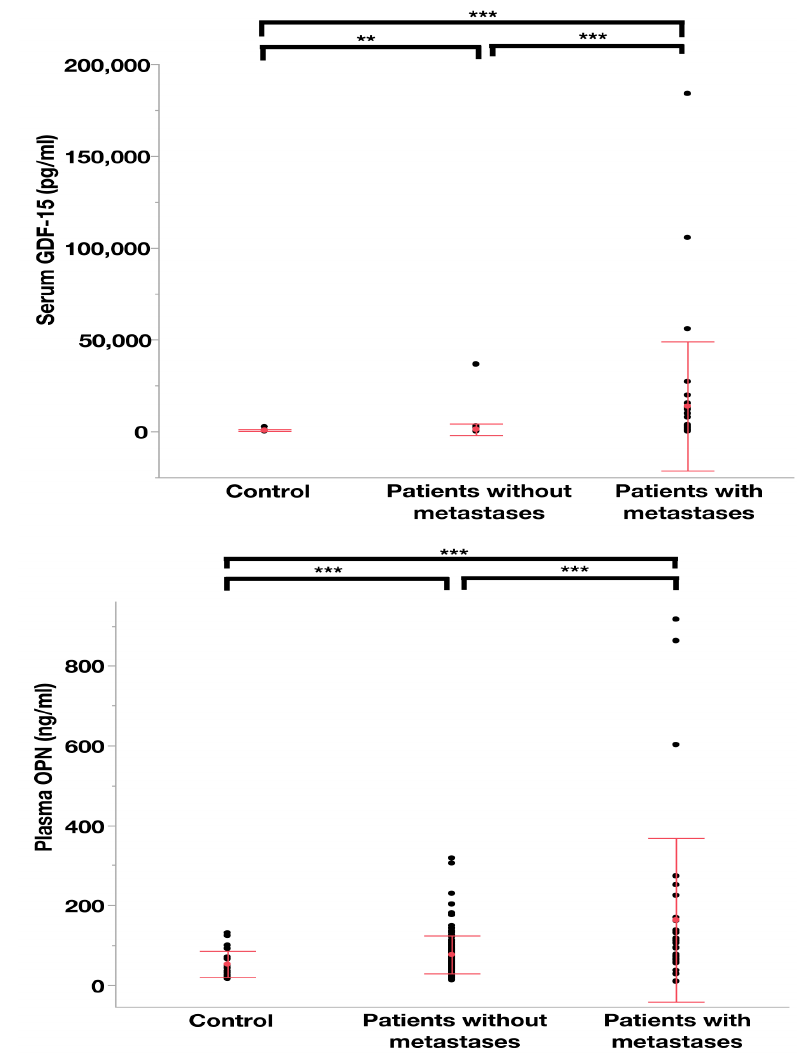
Figure 1. Scatter plots showing the distribution of blood-based levels of GDF-15 ( a ) and OPN ( b ) with mean (red point) and standard deviation (red lines) in control individuals, patients without and those with metastases. A one-way ANOVA and Tamhane post hoc analysis were conducted on the ln (Serum GDF − 15) and ln (Plasma OPN) , respectively. Note: *** means p < 0.01, ** means p < 0.05.